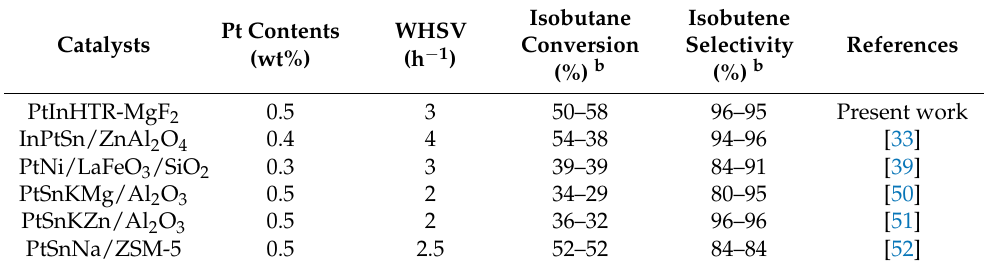
Table 2. Comparison of catalytic performance of various catalysts in isobutane dehydrogenation a .